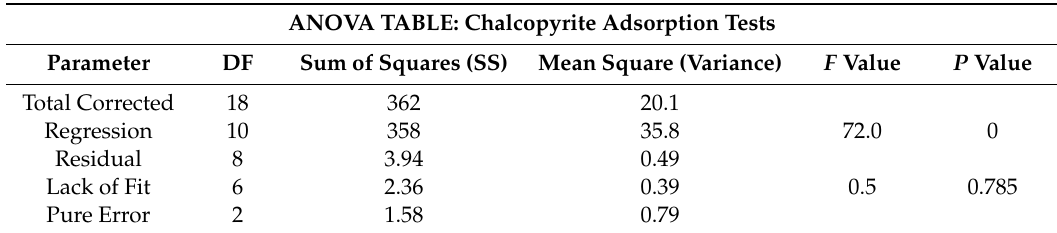
Table 5. ANOVA Summary for collector adsorption on chalcopyrite.